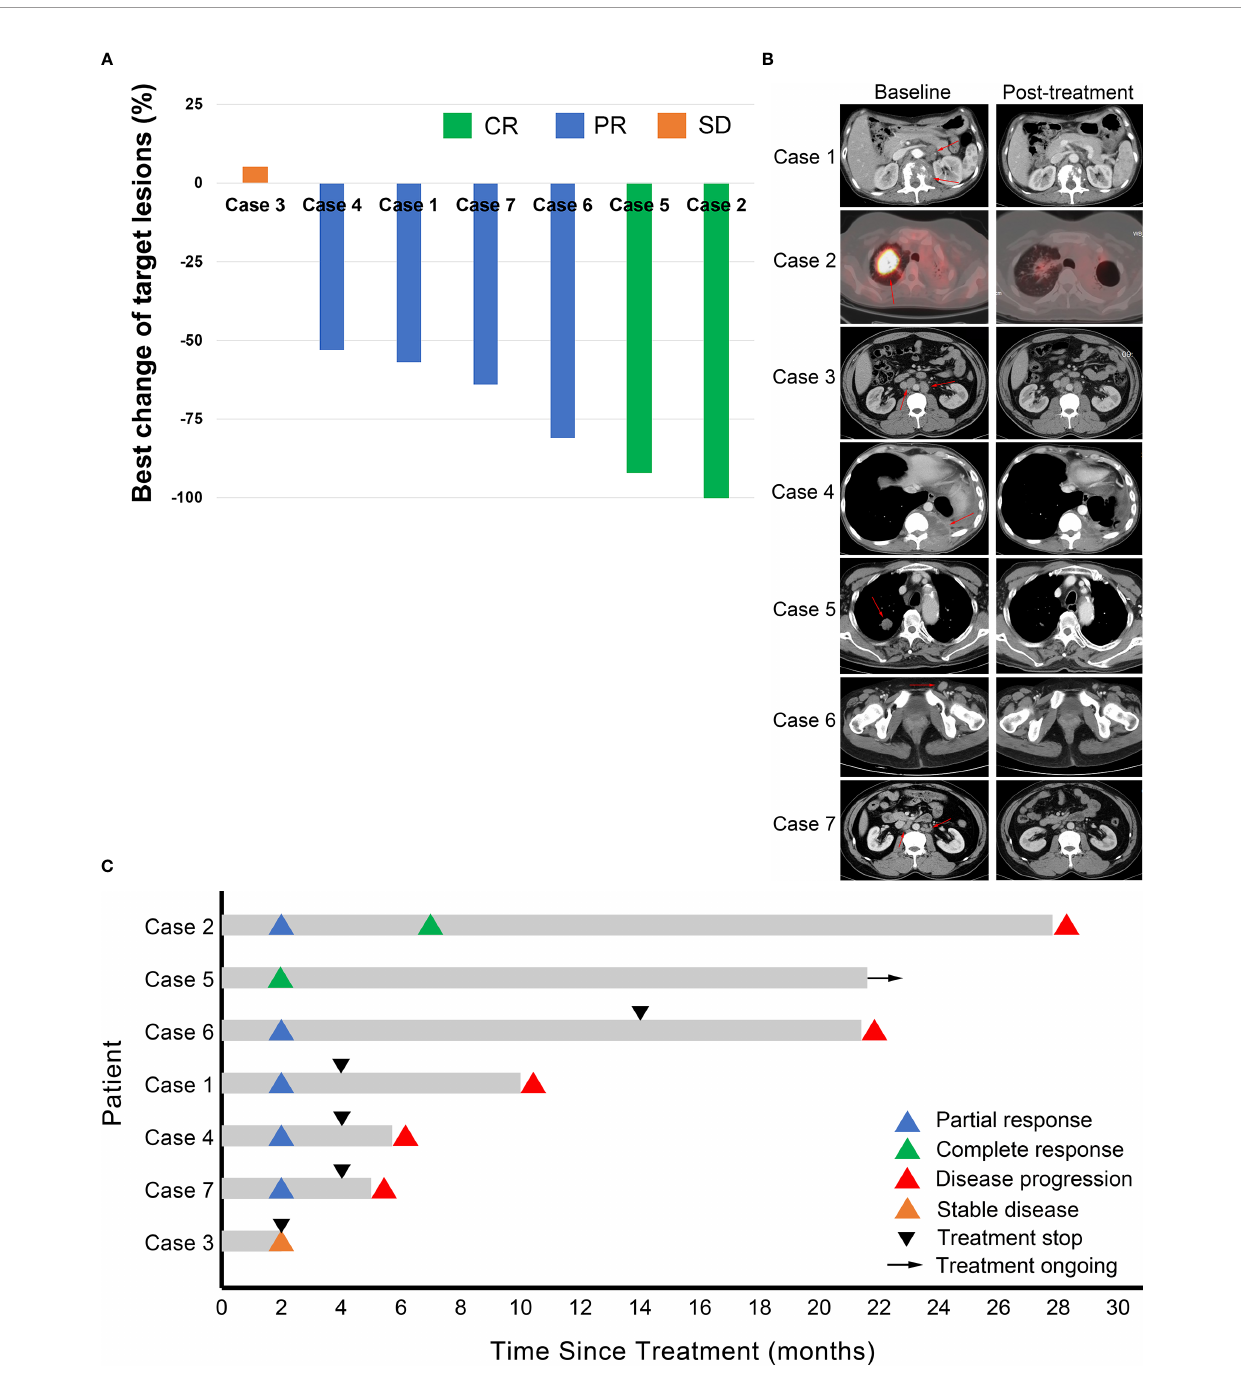
FIGURE 1 | Tumor response. (A) Waterfall plot for best changes in tumor volume. CR, complete response; PR, partial response; SD, stable disease. (B) Representative images of the 7 cases at baseline and after combination treatment of apatinib and camrelizumab. Red arrows point to the tumor lesions at baseline. (C) Duration of responses. The length of each bar represents progression-free survival of each